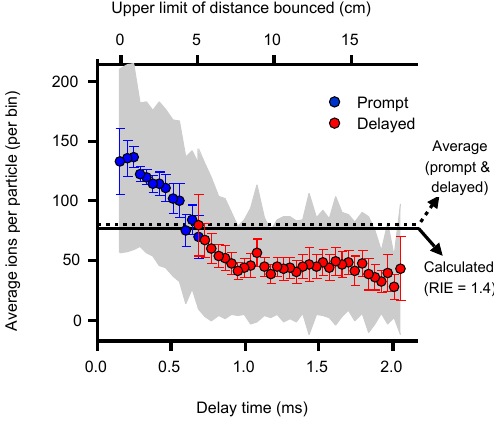
Figure 6. Average ions per particle as a function of delay time for SOA. Ions per particle as a function of the delay time between the expected time of arrival for the chemical ion signal and the actual time of arrival for 370nm SOA particles. The data points are the arithmetic mean IPP value for a given delay time bin. Error bars are the standard error of the mean for each bin, which represent the precision of the average IPP values. The gray shadow behind is the standard deviation of ions per particle within each bin, which re- flects the inherent spread of single-particle signals at a given delay time for monodisperse SOA. Dotted line shows the average IPP for the entire ensemble, while the solid line shows the calculated IPP based on an ionization efficiency (IE) of 5e-7 and an RIE of 1.4 for organics compared to ammonium nitrate. We also estimate the nominal distance bounced (top x axis) for these particles, assum- ing completely elastic collisions with the vaporizer and surround- ing surfaces and the average velocity of the size-selected particles measured between the chopper and